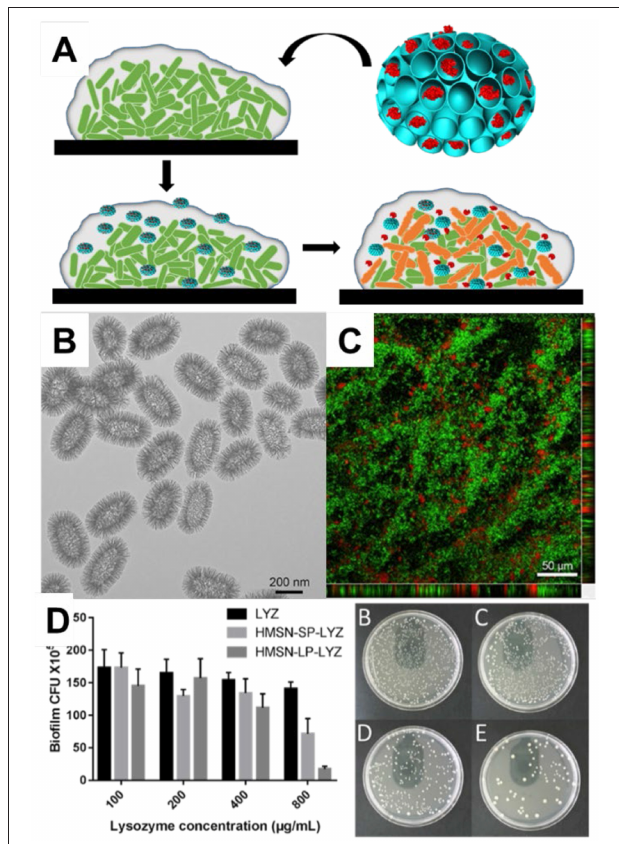
FIGURE 6 | Mesoporous silica nanoparticles for the delivery of antimicrobial protein into biofilm. MSNs for lysosome delivery. (A) the schematic drawing of MSNs delivery for biofilm. Panel (B) showed the TEM image of MSNs and (C) the penetration of MSNs into biofilm. The antibacterial performance was tested towards E. coli biofilm (D) . Reproduced from Xu et al. (2018) and by permission of The Royal Society of